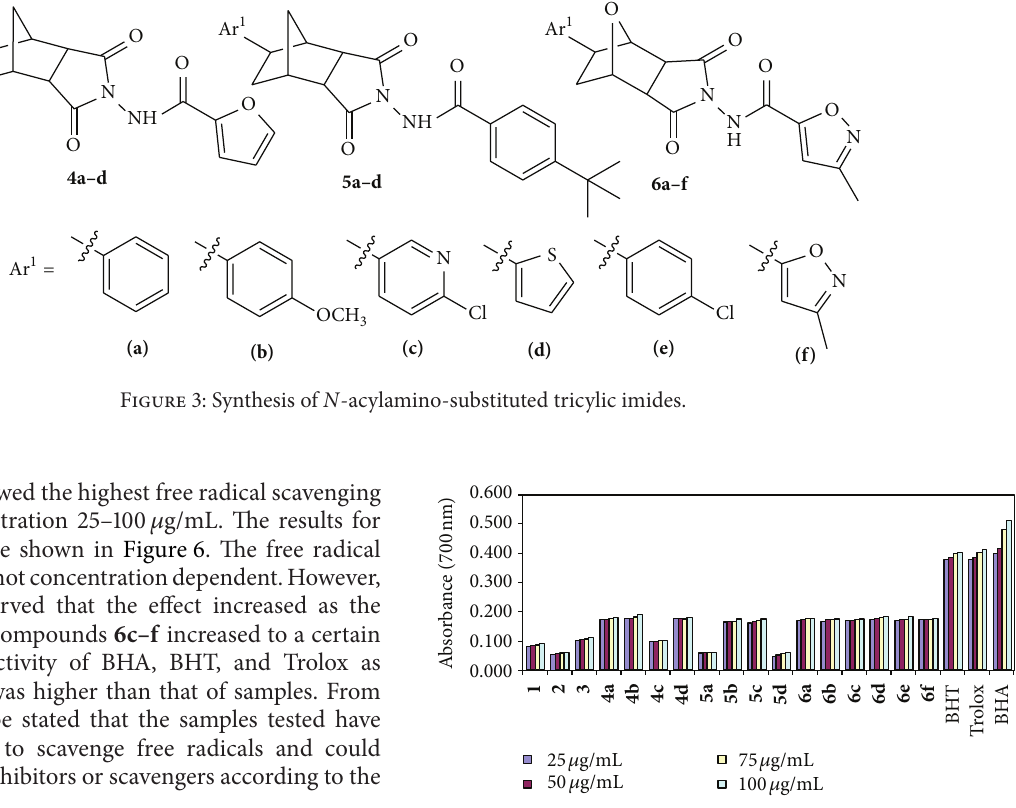
Figure 4: Reducing power activity of new